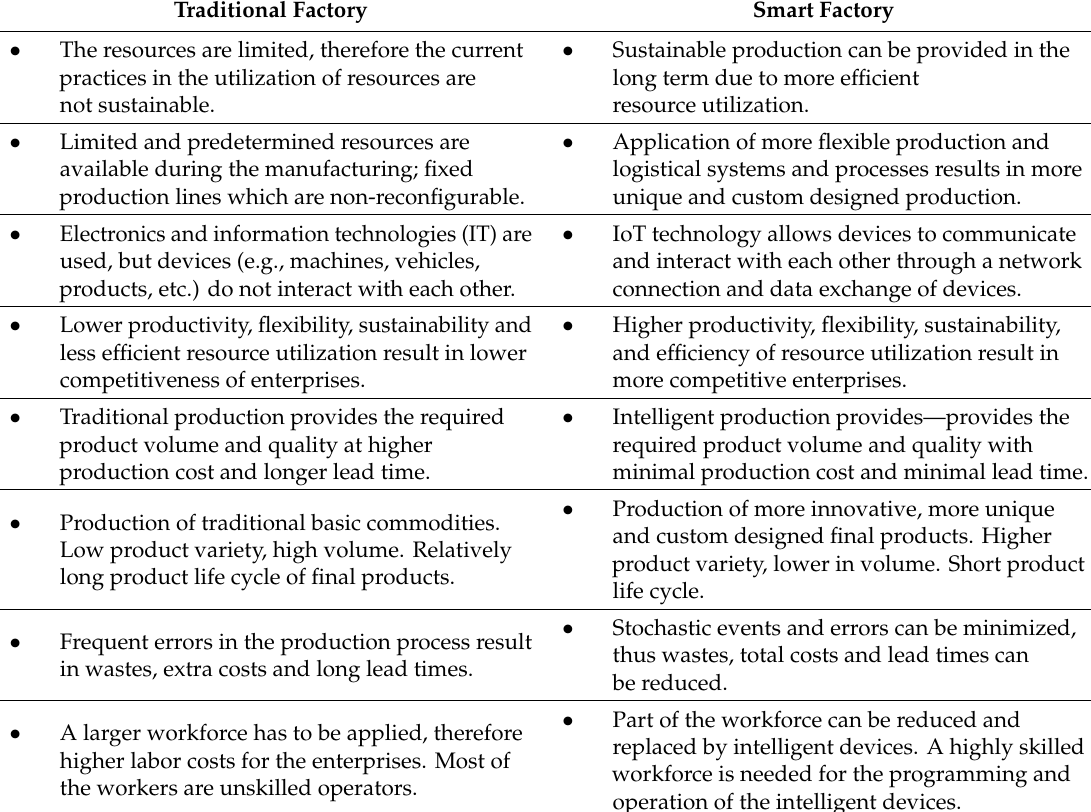
Traditional Factory Smart